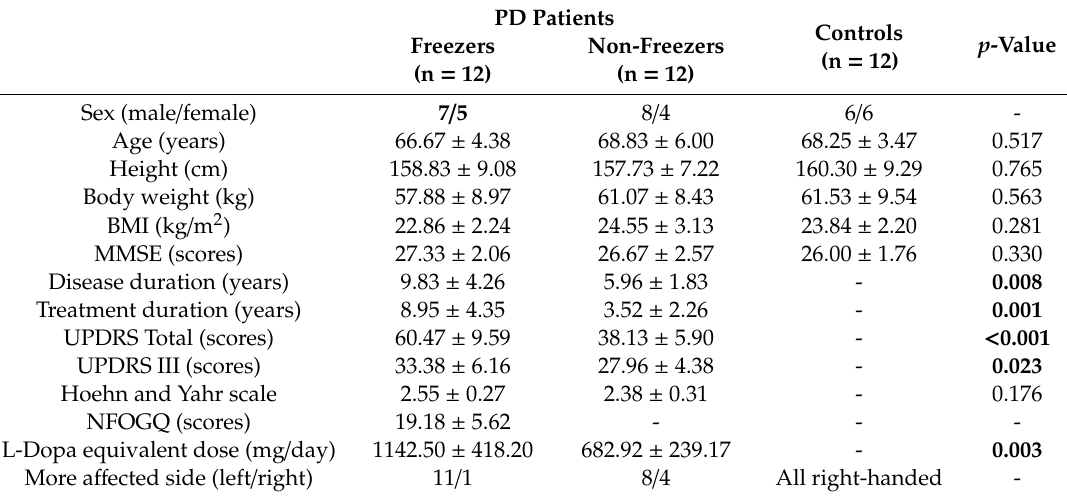
Figure 1. Consort flow diagram. NFOGQ: New freezing of gait questionnaire. Table 1. Physical characteristics of all participants.